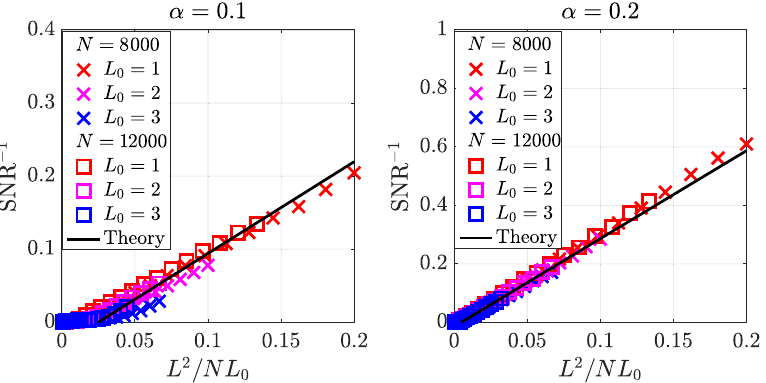
1 2 / NL Figure 5. SNR − v. L 0 shown for N items contained in 10, 000 memories shown for α 0.65 . T 20 parallel updates are used for with c = =